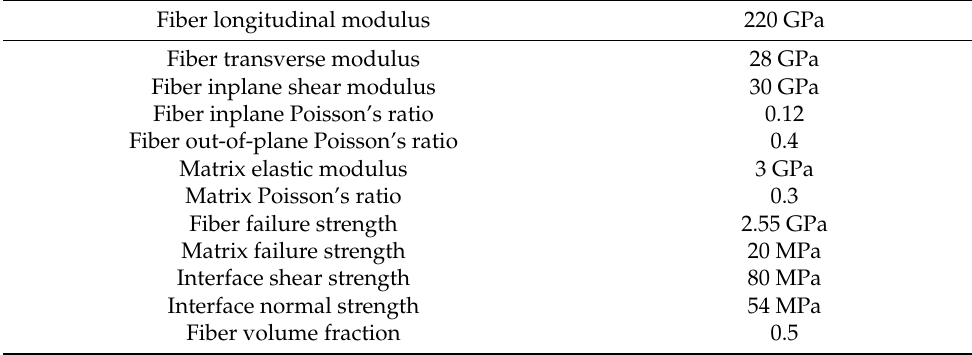
Table 1. Material properties of fiber and